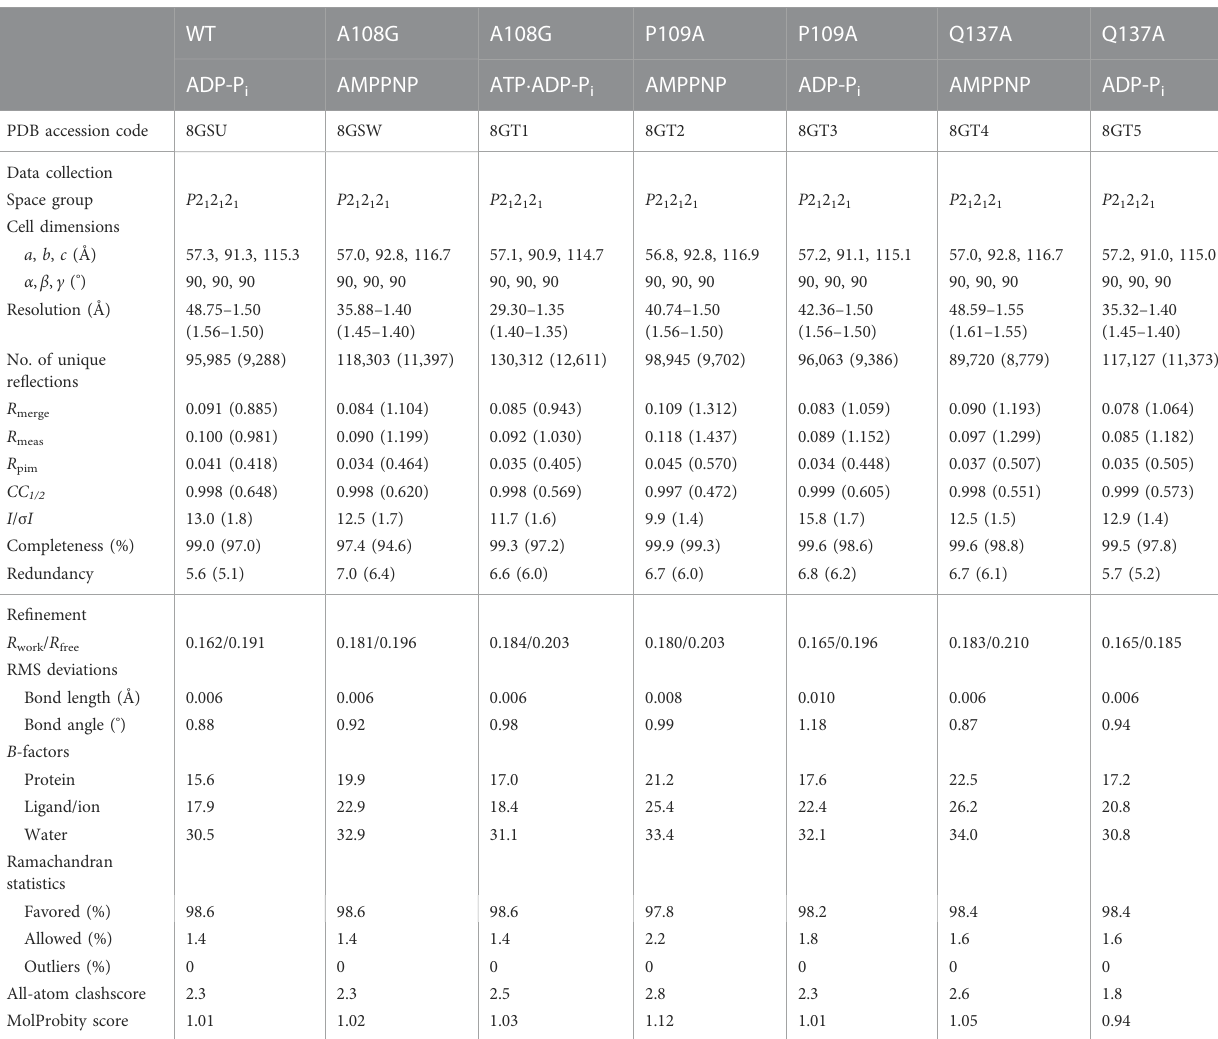
TABLE 1 Data collection and re fi nement